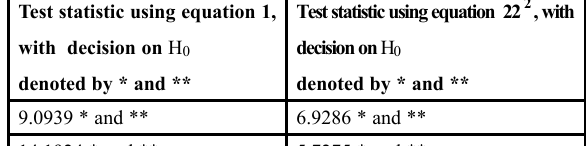
Table 5: Test statistics for hypotheses tests on mean refractive state. The respective null hypotheses (H 0 ) are those presented Table 4a. Critical values are: (for mutually orthogonal linear contrasts: F0.05, 3, 143 = 2.673 and F0.01, 3, 143 = 3.918) and (for comparison of multivariate means: F0.05, 3, 56 = 2.776, and F0.01, 3, 56 =